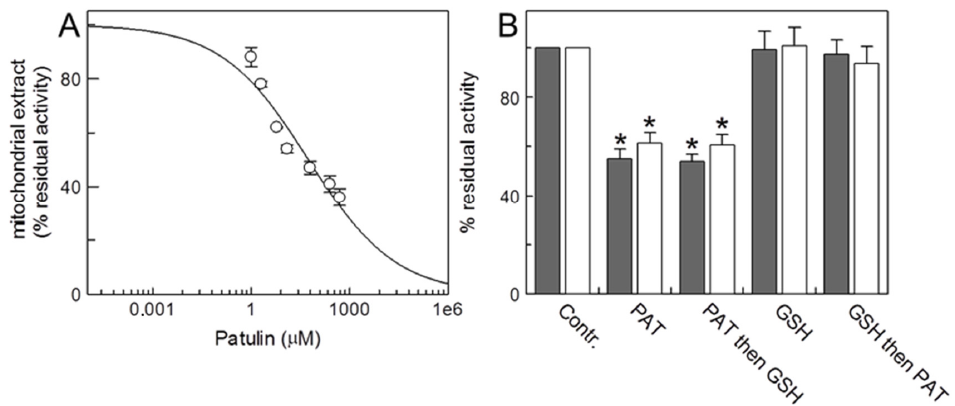
Figure 1. Effect of Patulin on the native carnitine/acylcarnitine carrier (CAC). ( A ) Dose-response analysis of proteoliposomes reconstituted with the CAC extracted from rat liver mitochondria (0.3 mg of total proteins) and incubated with PAT at the indicated concentrations for 30 min, before measuring the transport activity by adding 0.1 mM [ 3 H] carnitine for 10 min as described in Materials and Methods. The percentage of residual activity compared to control, without PAT treatment, is reported. The values are the means ± SD from three independent experiments. ( B ) Rat liver mitochondria (5 mg/100 µ L) were incubated or not (control) for 60 min, with Patulin (60 µ M) or GSH (5 mM) as indicated. Upon treatment, the unreacted drug was removed by washing the mitochondria in PBS 1X and then 0.3 mg mitochondria were solubilized by 3% TX-100, 10 mM PIPES pH 7.0 and reconstituted in proteoliposomes for transport assay as indicated in ( A ) and Materials and Methods. Black and white bars indicate without or with the addition of 5 mM dithioerythritol (DTE) 1 min before the transport assay to aliquots of each sample. The data are expressed as the percentage of the controls (no addition of PAT) and are means ± SD from three independent experiments; significantly different from the respective control as estimated by Student’s t -test (* p <